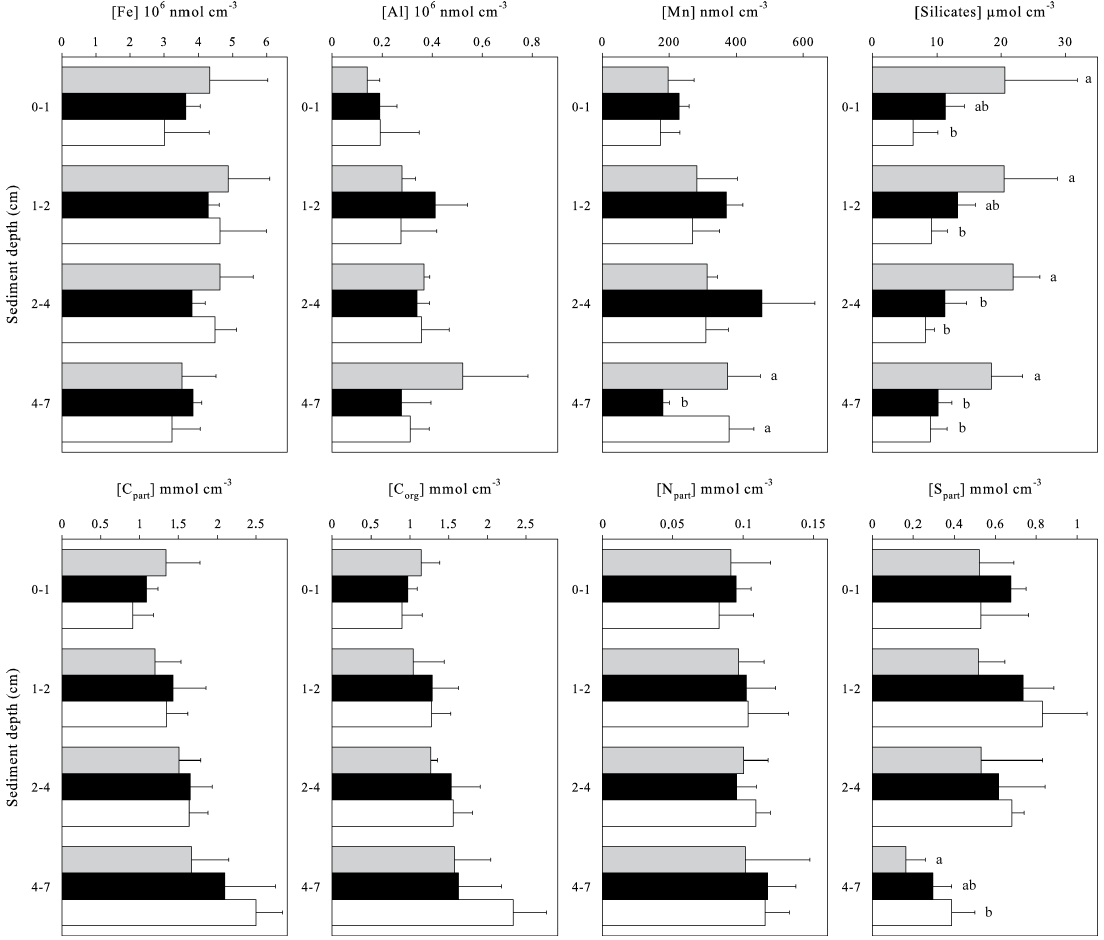
Fig. 5. Averaged content of the main solid chemical species in the first 7cm of the sediment (0–1, 1–2, 2–4 and 4–7cm layers) per sediment volume at initial conditions (Control: C, grey bars) and after 16 days in the different treatments (Defaunated: D, black bars; with chironomids: Chir, white bars). Means ± SD ( N = 4). For the averaged data, 42 ± 7% of sediment samples are explained by the analysis. Same letters or absence of letters on graphs indicate no significant difference between